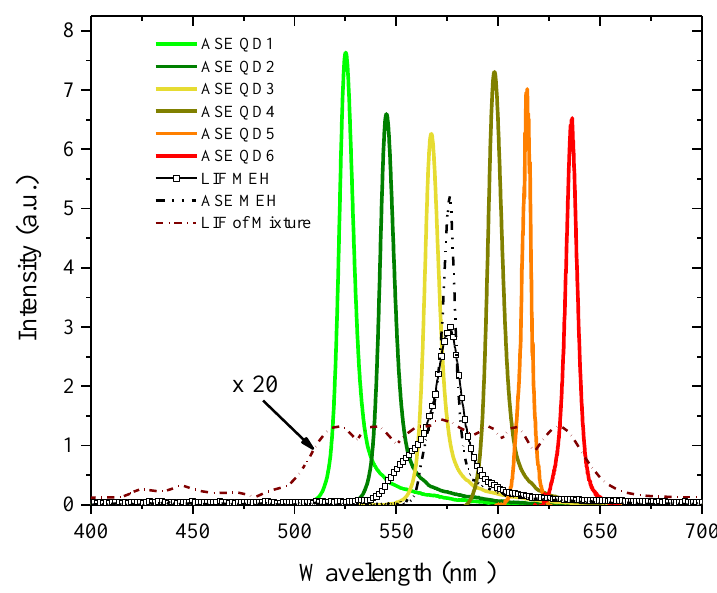
Figure 6. The energy transfer from PFO and MEH-PPV to QDs; here, the ASE efficiency was improved at least three-fold from the prior condition to the energy transfer. The performance of QD 4, QD 5, and QDs 6 increased notably after the addition of MEH-PPV.